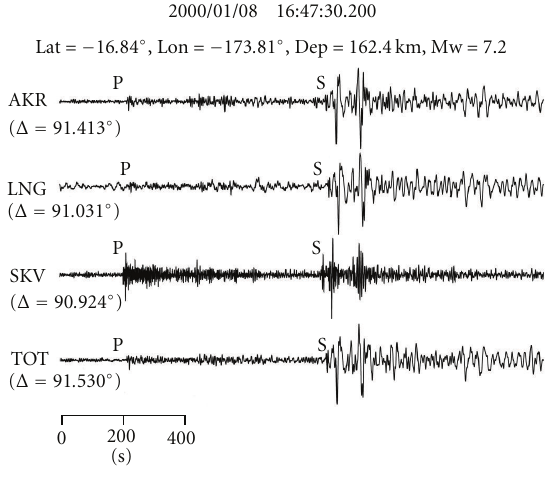
Figure 4: Example of the teleseismic waveforms (Fiji Island region) recorded at the GARNET stations deployed at LHB.